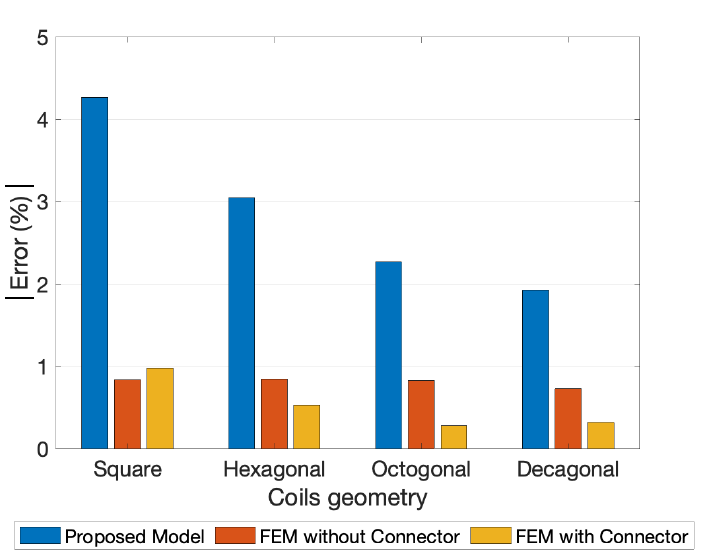
Figure 18. Relative errors module between the Experimental Measurements, the FEM simulations and the proposed model for the 2-layer coils with 10 turns, w = s = 0.15 mm, and a 1.3 mm inner